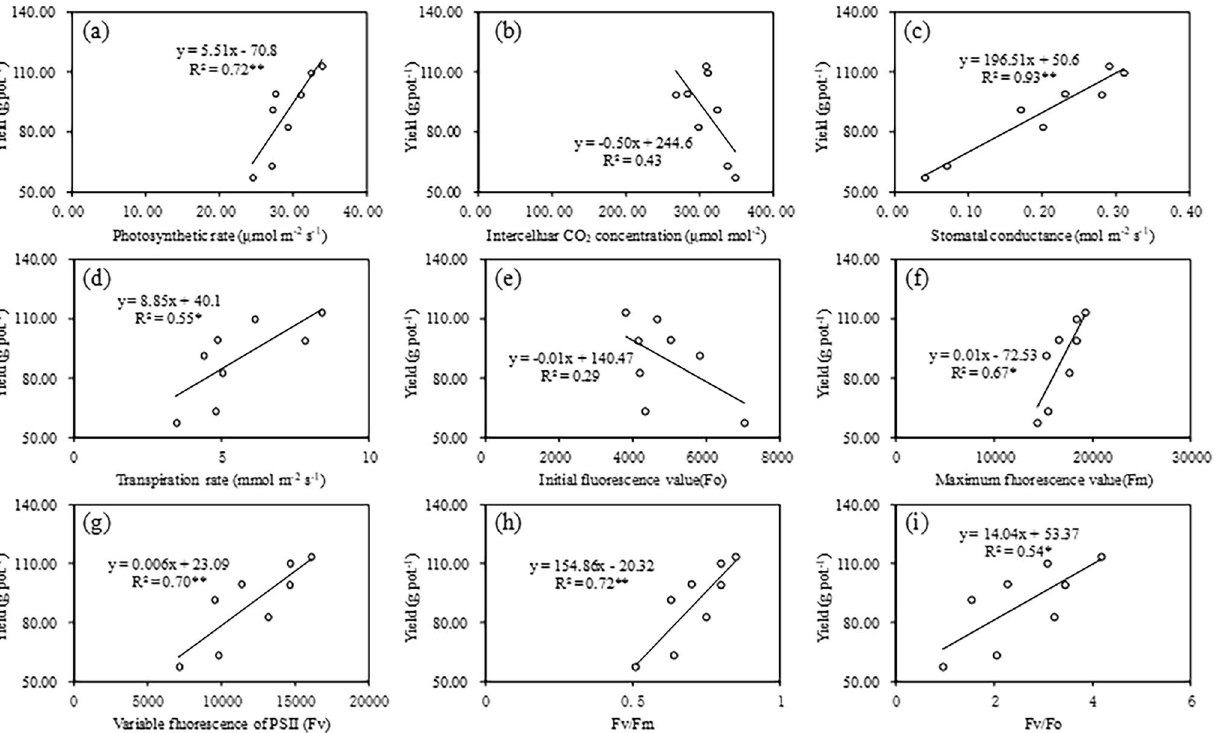
Figure 5. Relationship between the naked oat yield and photosynthetic rate ( a ), intercellular CO 2 concentration ( b ), stomatal conductance ( c ), transpiration rate ( d ), initial fluorescence value ( F o) ( e ), maximum fluorescence value ( F m) ( f ), variable fluorescence of PSII ( g ), F v/ F m ( h ) and F v/ F o ( i ) in the Bashang area, Hebei Province, China. The solid line represents the linear trend for each variable. * P < 0.05. ** P <